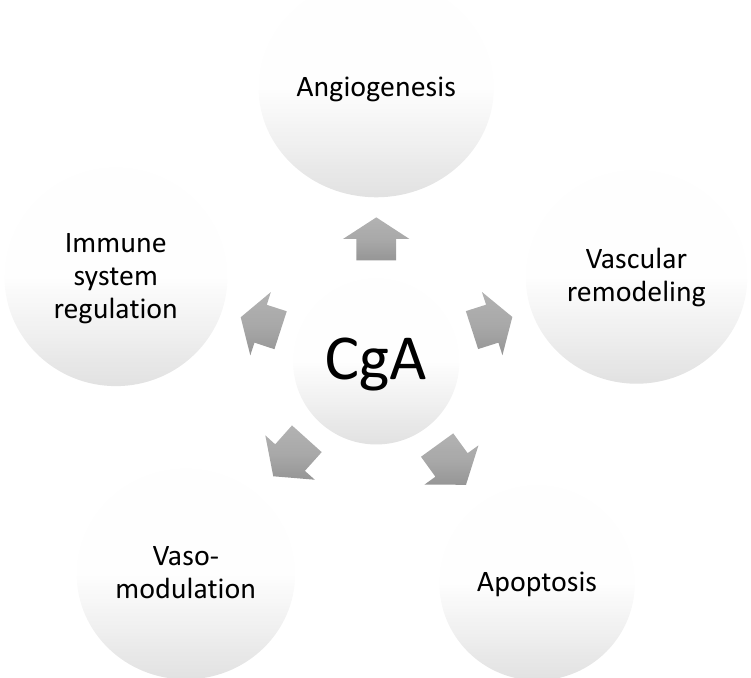
Figure 2. Processes of pregnancy regulated by chromogranin A (CgA). Table 2. CgA-derived peptides and their most important biological